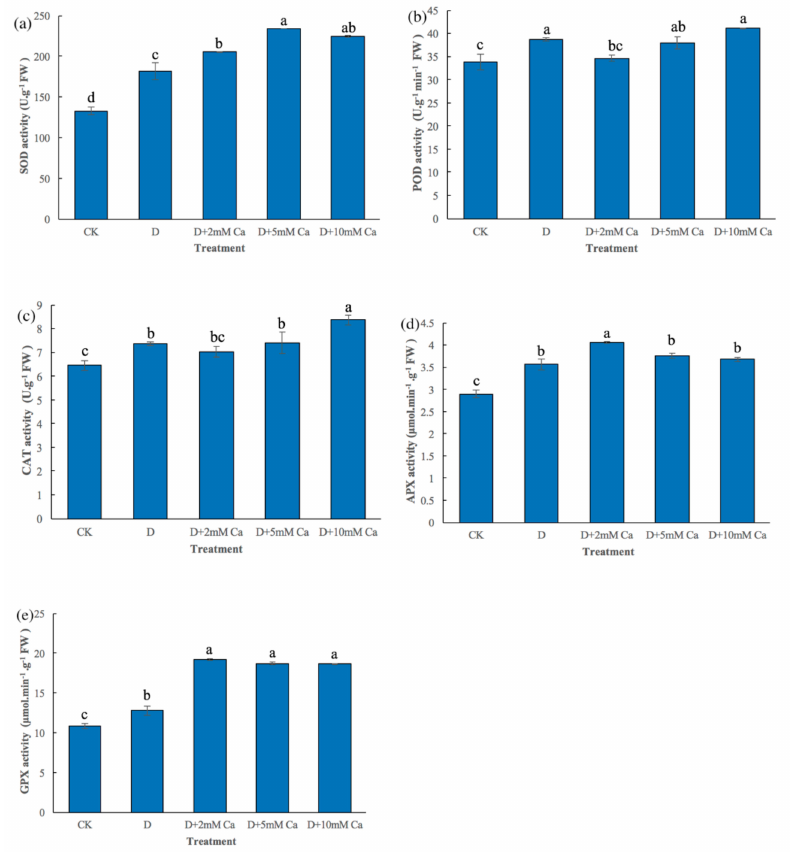
Figure 4. E ff ects of exogenous calcium on peroxidase (POD) ( a ), superoxide dismutase (SOD) ( b ), catalase (CAT) ( c ), ascorbate peroxidase (APX) ( d ) and glutathione peroxidase (GPX) ( e ) activities in H . bodinieri under drought